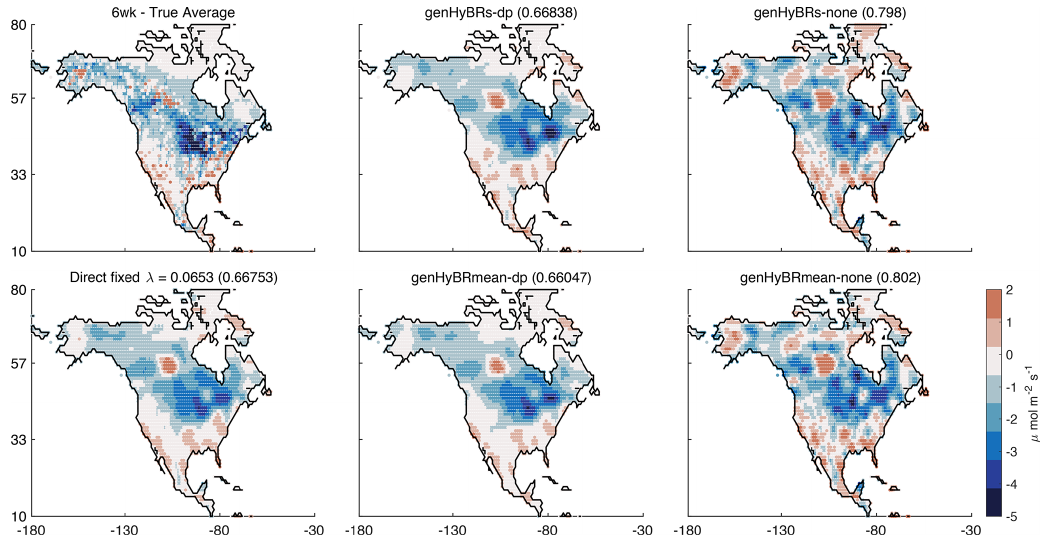
Figure 4. Six-week case study: reconstructed fluxes, averaged over 6 weeks, are provided for genHyBRs and genHyBRmean for the automatically selected DP parameter and for λ = 0. The true average fluxes and the reconstruction using a direct method with the optimal regularization parameter computed from genHyBRmean are provided for comparison. These results correspond to the 50% noise level, and relative error norms of average fluxes over 6 weeks are provided in the titles.